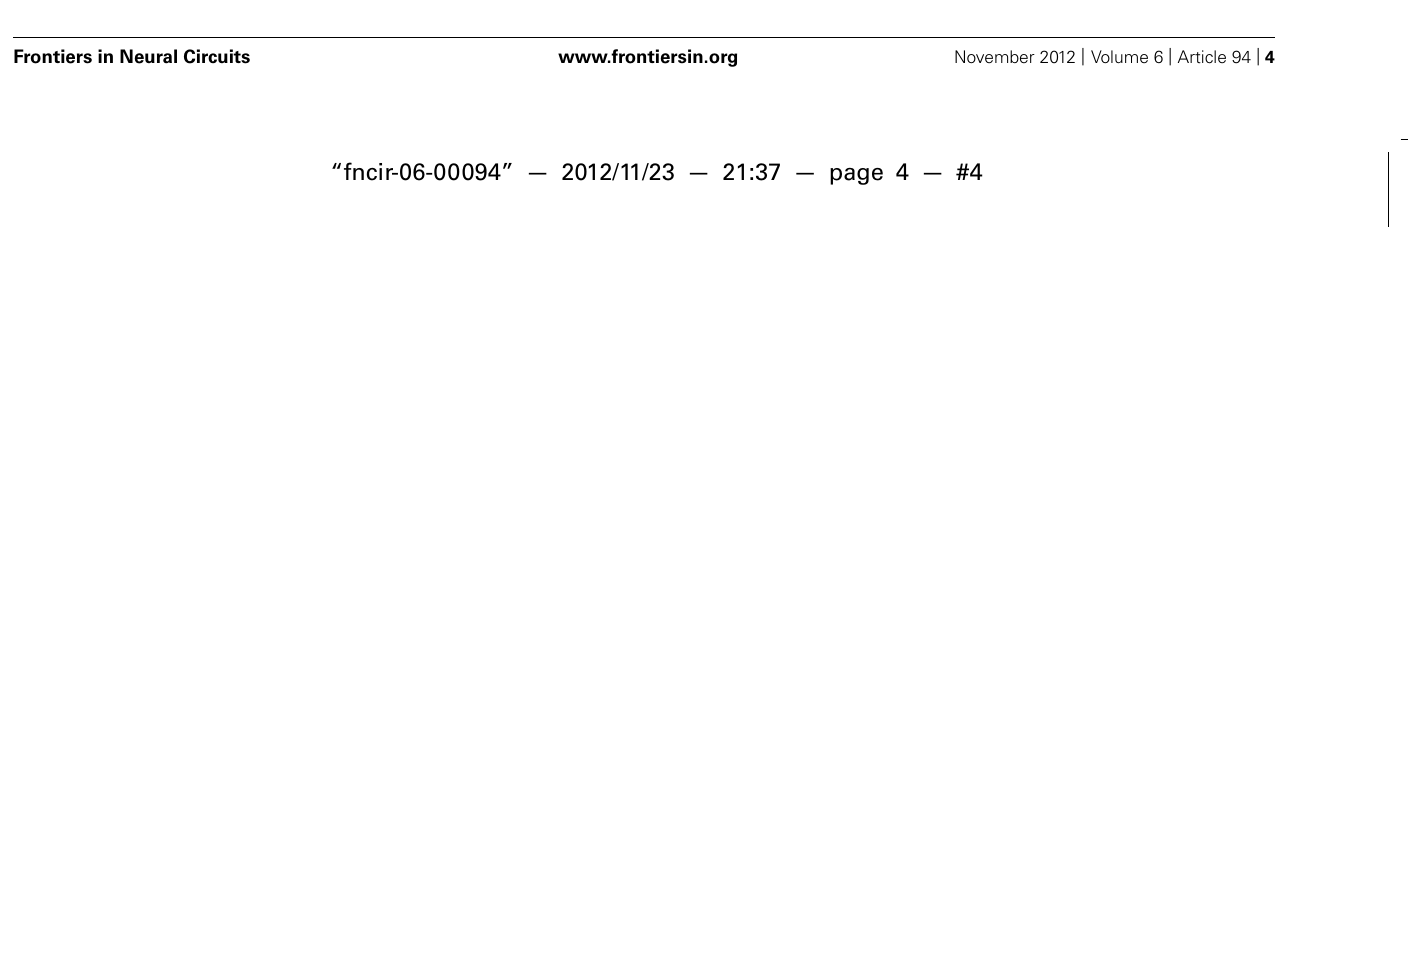
the assumption that the first wash-out was the control of the second application ofTHDOC (notice that the data of the second wash-out are aligned effect. (C) TheTHDOC response was blocked by GBZ 1 μ M. Excitability plot (red: excitatory; black: inhibitory neurons) and inter-burst interval plot (IBI, blue dashed-line) during control,THDOC (1–300 nM), GBZ 10 μ M and againTHDOC (1–300 nM), then wash-out for 30–150 min. After wash-out, the excitability of inhibitory neurons was depressed while that of excitatory neurons recovered to control values. (D,E) Plots of normalized excitability for inhibitory and excitatory clusters in three different experiments. (F,G) Plots of engaged neurons in the same experiments. Different symbols represent data derived from different neocortical cultures ( n = 3).The ratio of excitatory and inhibitory neurons was 67/13, 84/14, and 86/16 respectively in the three